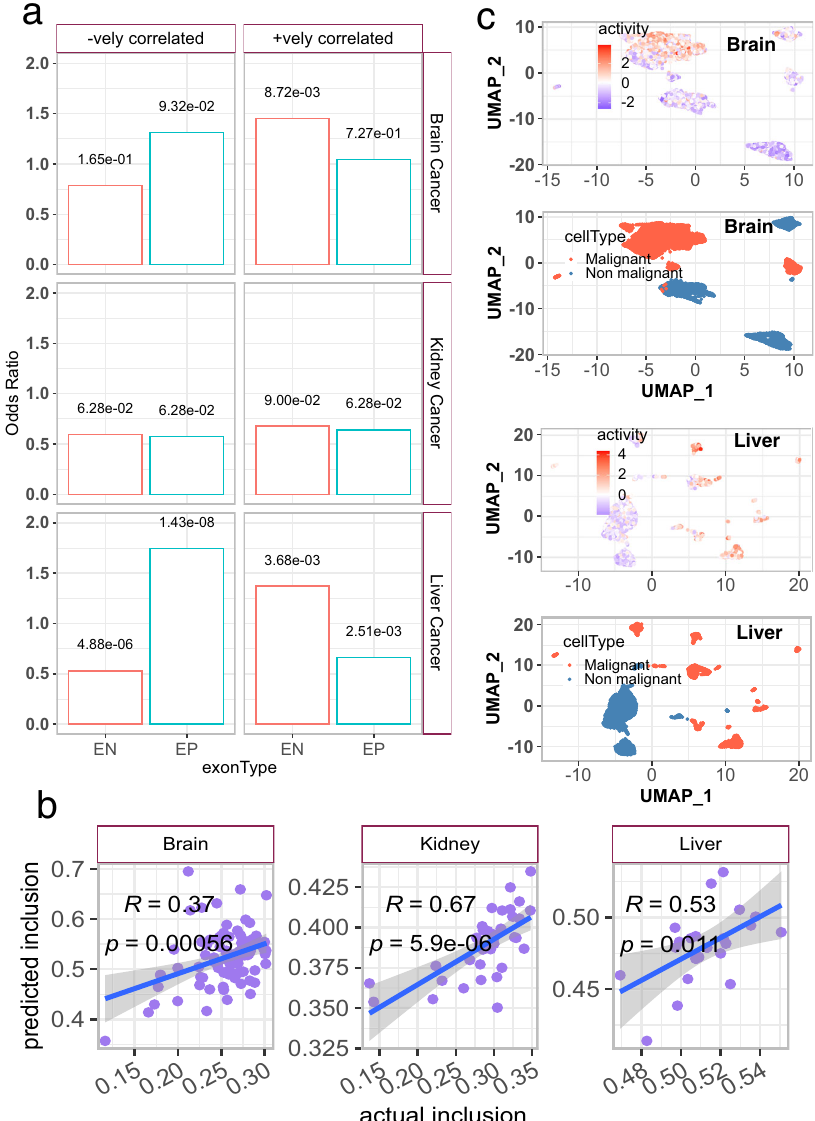
Fig.5|Embryonicsplicingeventsandtheirregulatorsincancercelllines.a Bar plots showing the odds ratio for enrichment/depletion of embryonic positive (EP) and embryonic negative (EN) events among the exons having strong positive (+vely) and negative ( − vely) correlation with the doubling time of cancer cell lines (obtained from DepMap portal) corresponding to brain, kidney, and liver. FDR- adjustedtwo-sided p -valuesobtained from theFishers ’ testare shownnextto each bar. b Scatter plot of the observed and predicted median inclusion level of EP